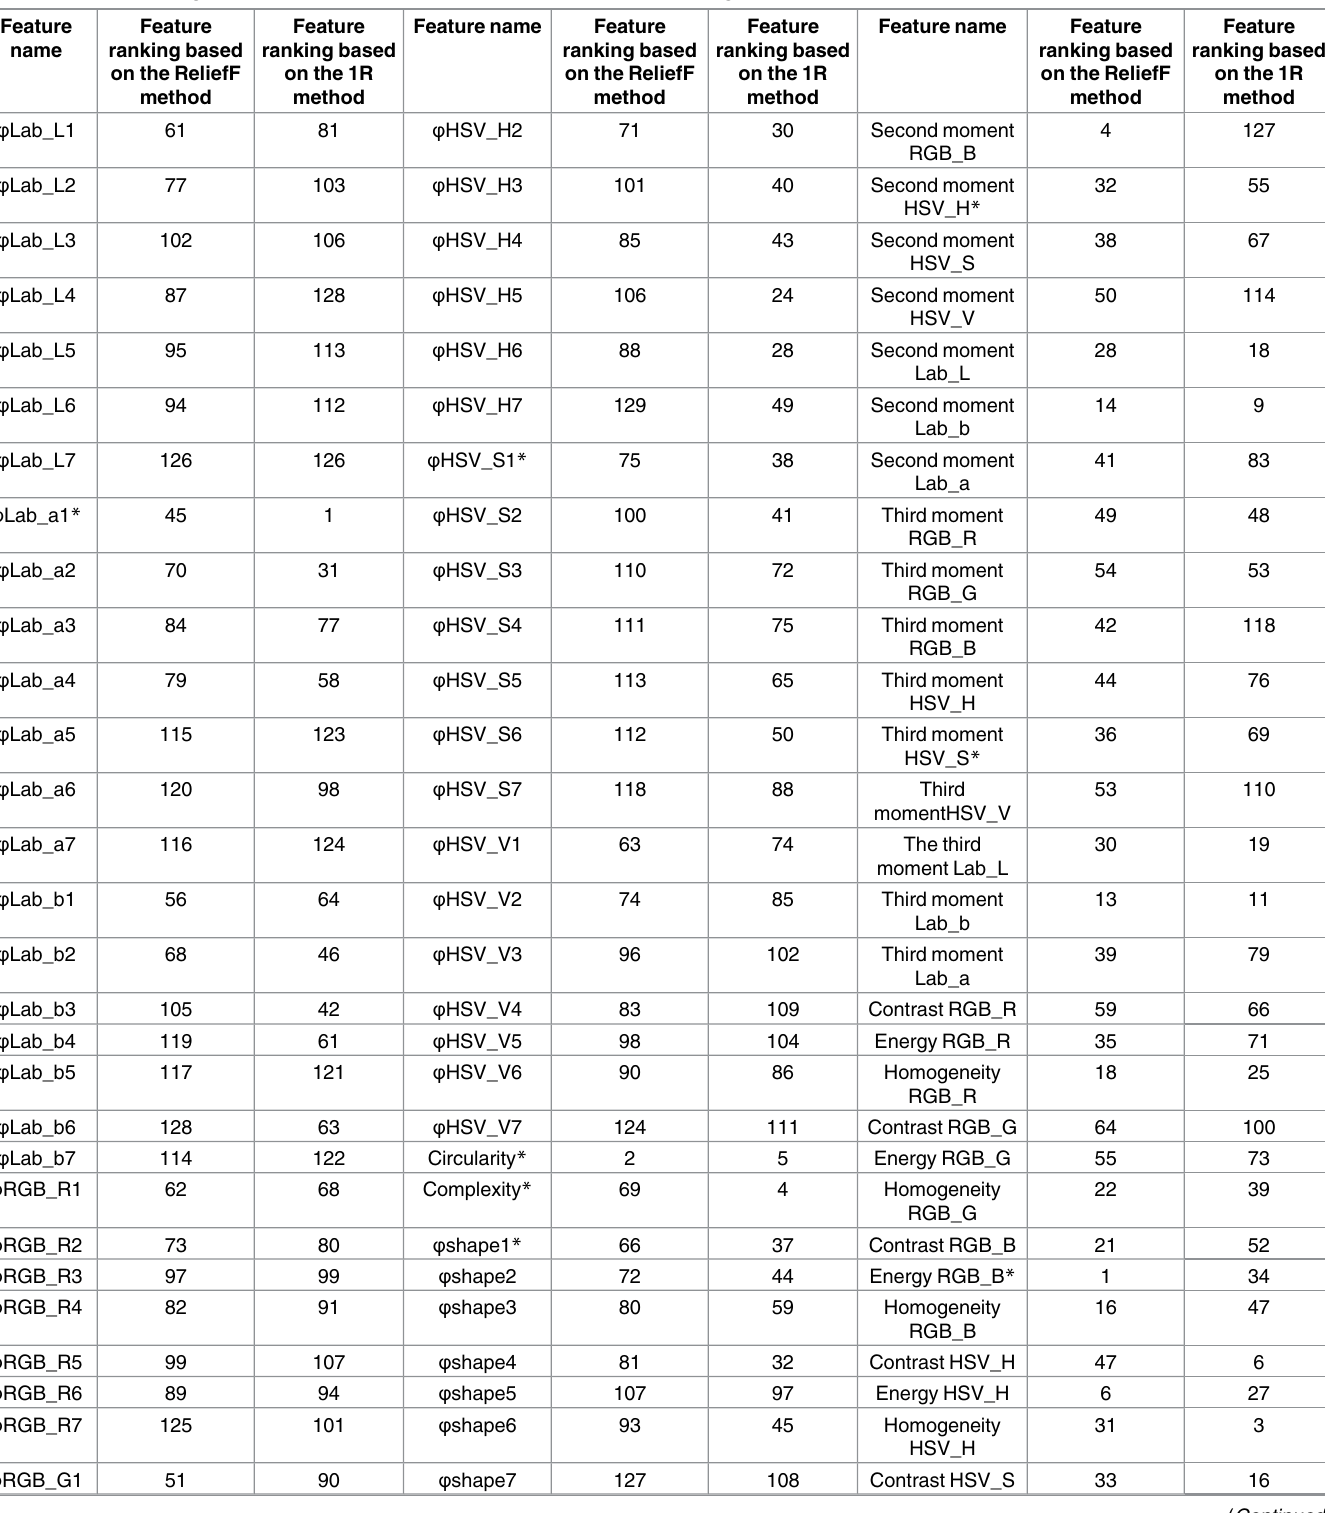
Table 3. Namesof image featuresextractedand results of feature selection using the ReliefF method, the 1R method and the CFS